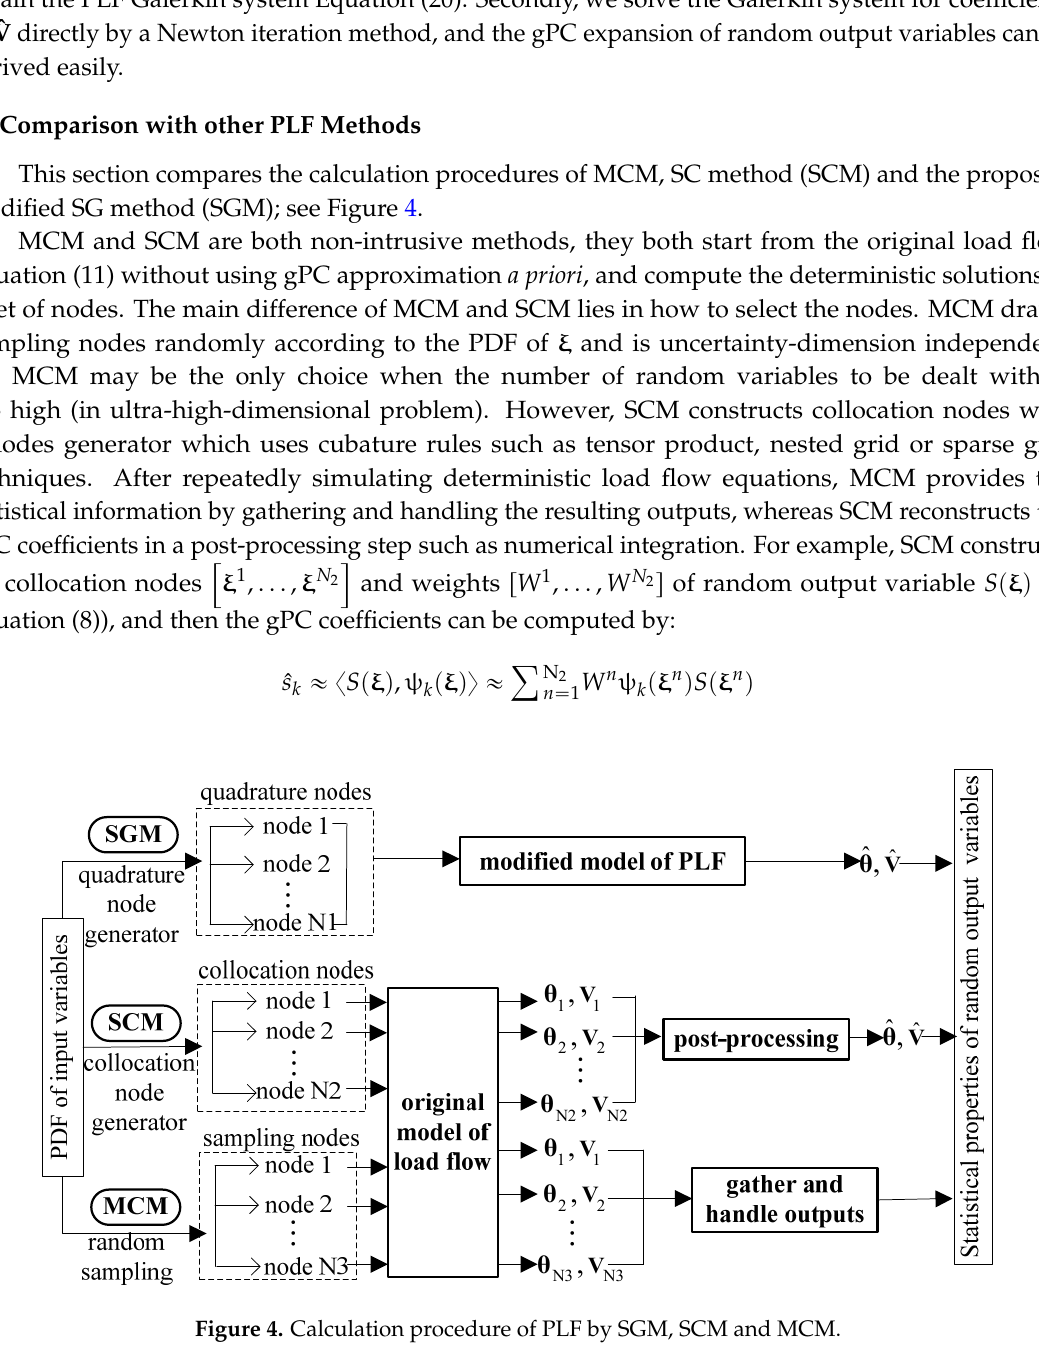
Figure 5. Modified calculation model of SG ‐ PLF. If the original load flow Equation (11) are solved by P ‐ Q fast decouple method, and the time cost of solving is